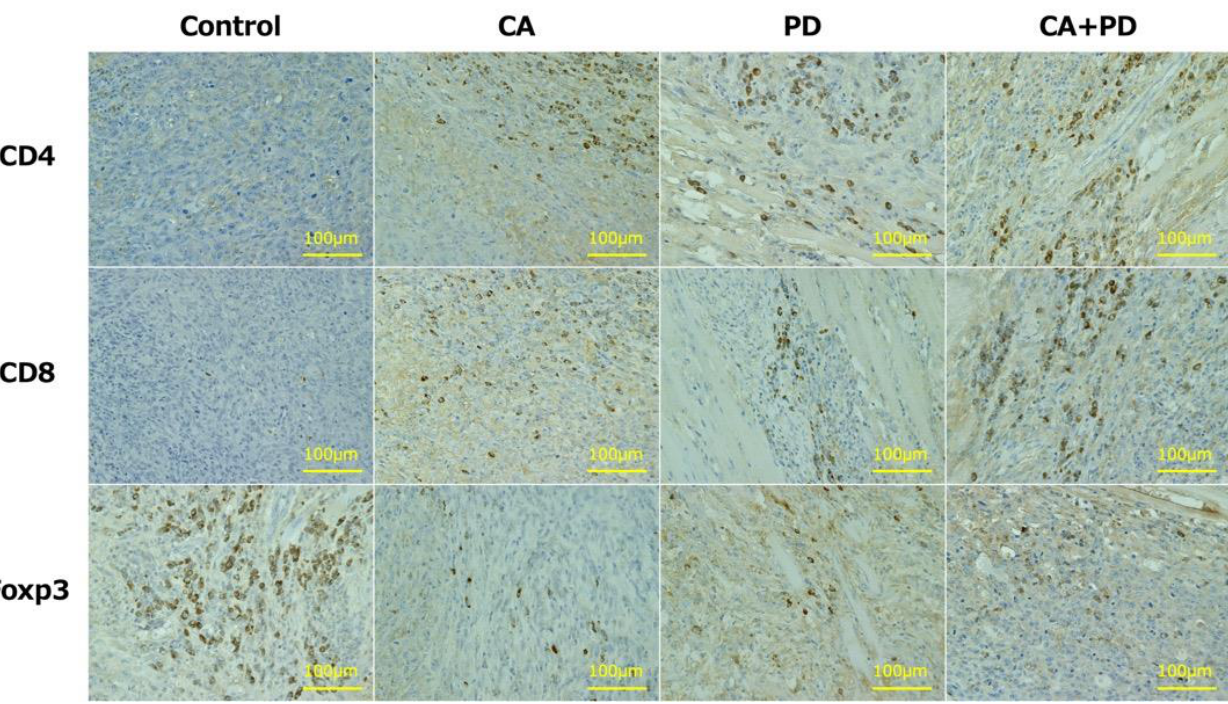
Figure 6. Representative findings of immunohistochemistry for CD4, CD8, and Foxp3 in each group. Expressions reveal a cytomembrane pattern.